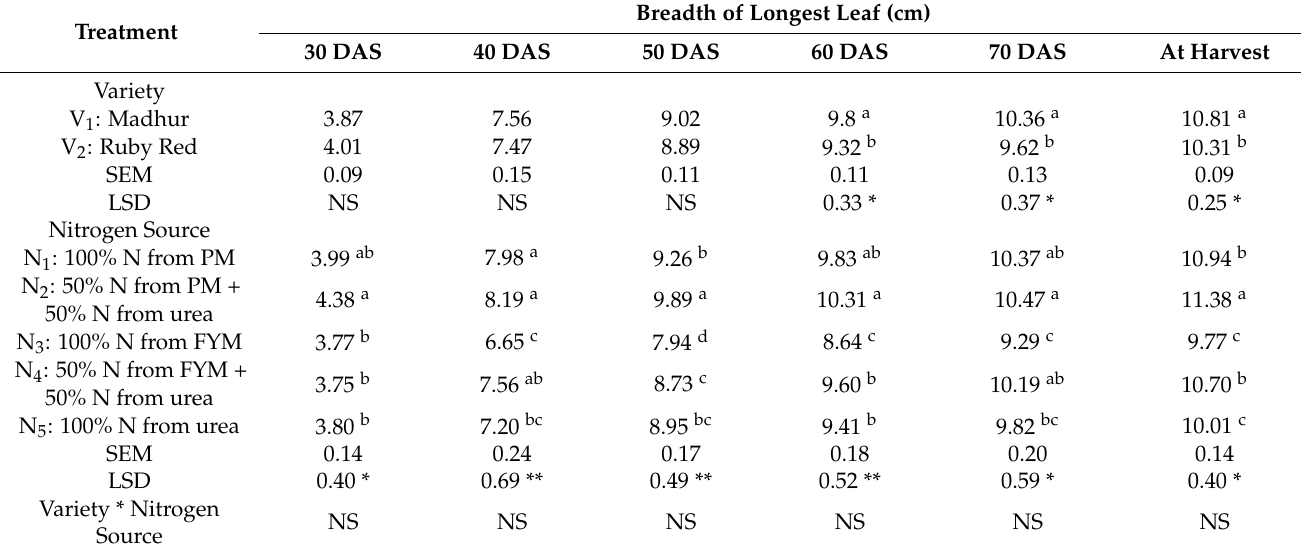
Table 5. Effect of variety and nitrogen source on leaf breadth of beetroot at different stages at AFU, Rampur, Chitwan in